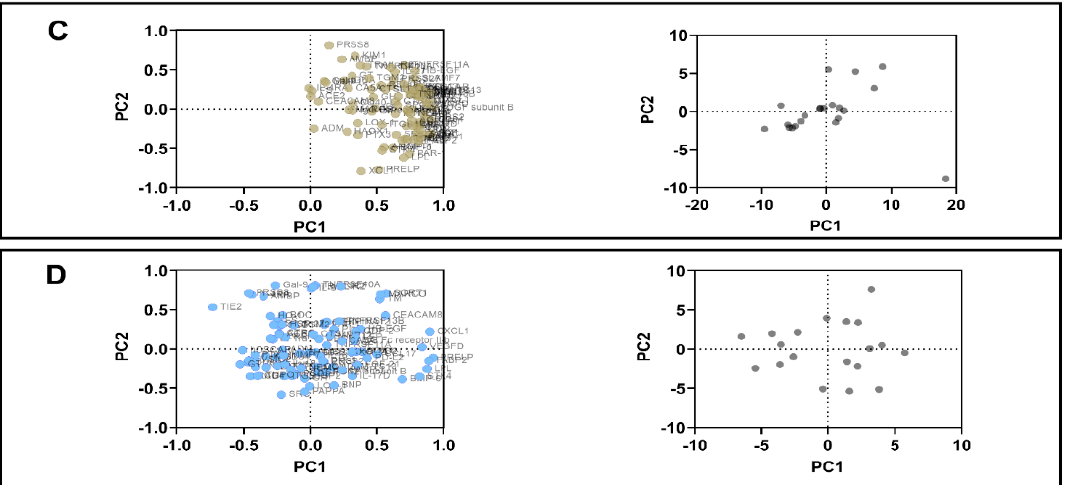
Figure 2. PCA analysis. The principal component analysis showing loadings (left side) and scores (right side) RA with PD (panel A ), PD (panel B ), RA without PD (panel C ), and controls (panel D ). Table 3. PC loadings for disease groups.